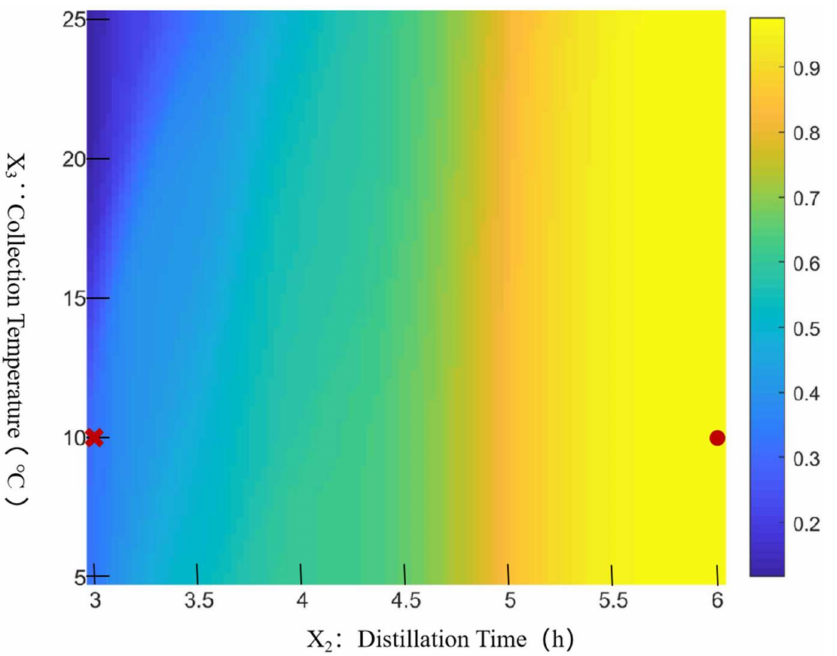
Figure 7. Two-dimensional design space diagram (water addition was fixed at 10 mL/g; “ ” is the verification point outside the design space; “ ” is the verification point inside the design space; and the color bar on the right is the probability of meeting the standard.).